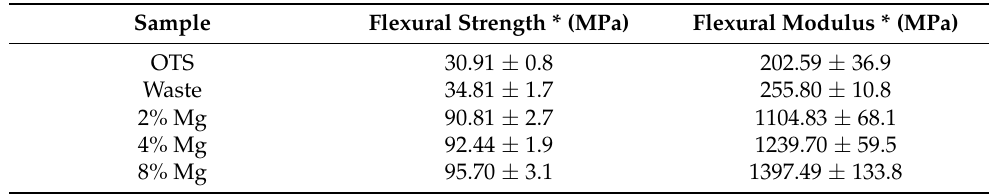
Figure 7. Flexural stress–strain profiles for different prints obtained from three-point bending tests. Table 5. Flexural testing Table 5. Flexural testing results.